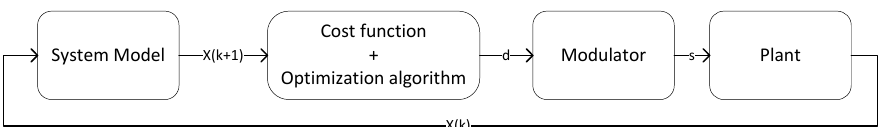
Figure 3. Continuous control set model predictive control (CCS-MPC).